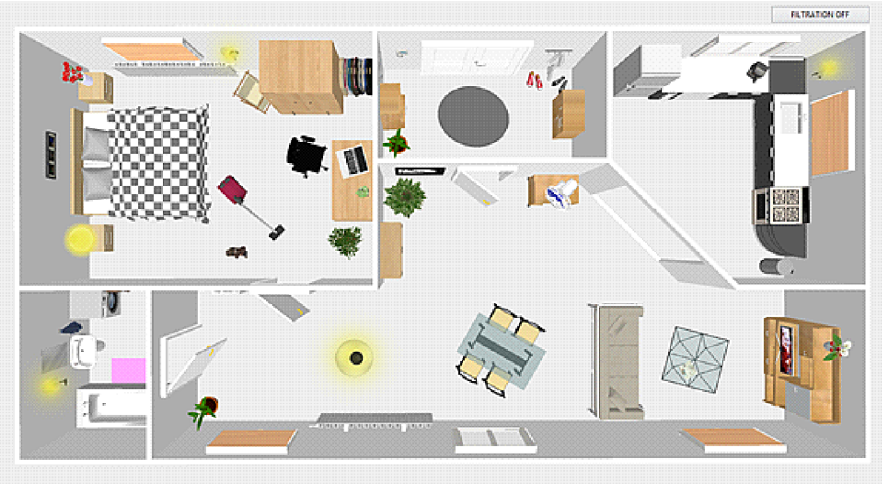
Figure 4. Front panel of the “smart home”